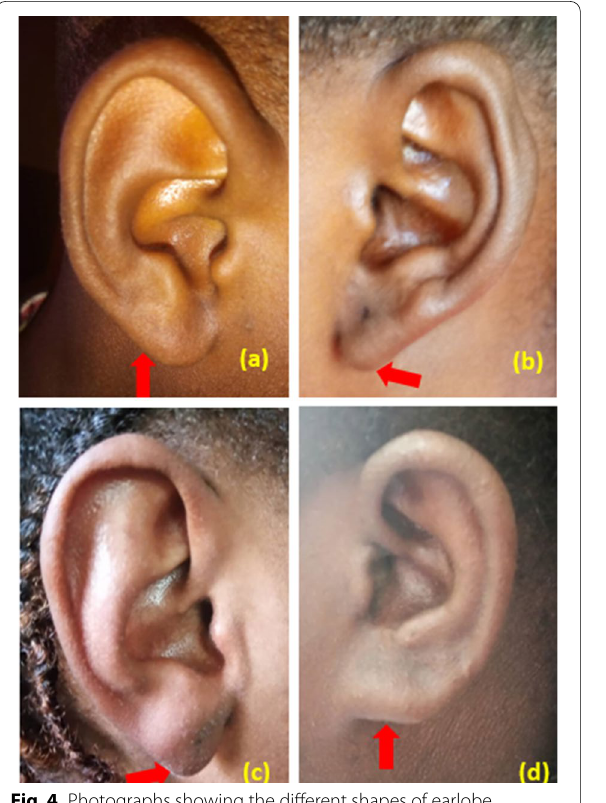
Fig. 4 Photographs showing the different shapes of earlobe (arrowed): arched ( a ), triangular ( b ), tongue ( c ), square ( d )